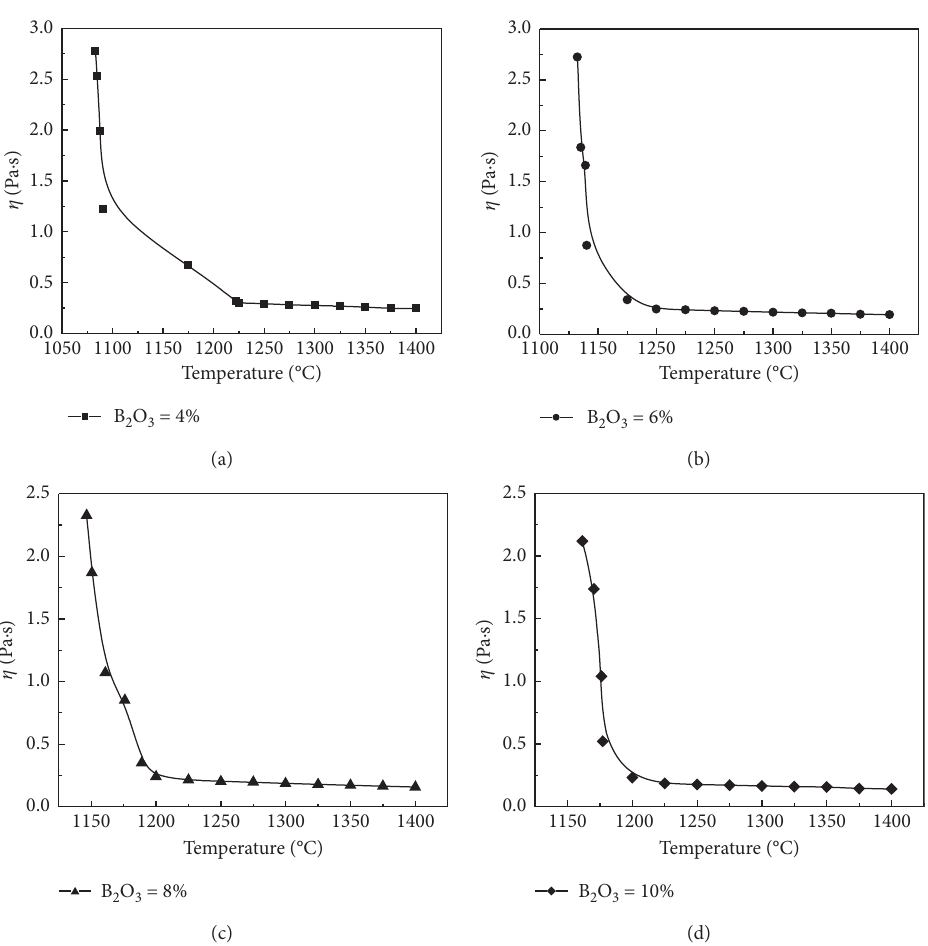
Figure 6: Viscosity of mold fluxes as a function of the B